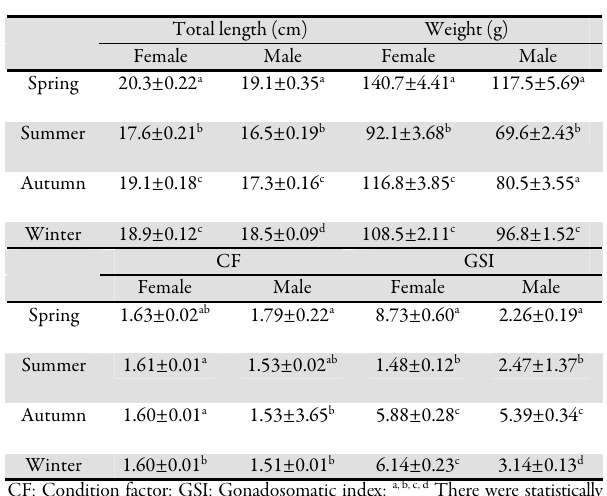
Table 6. Statistical analyses of C. gibelio individuals between seasons